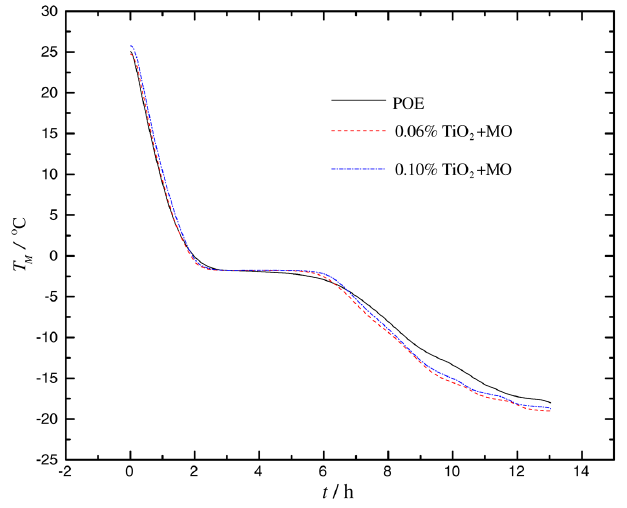
Figure 17. Freezing capacities of HFC134a/POE oil and HFC134a/mineral oil/TiO 2 nanoparticle systems [38].